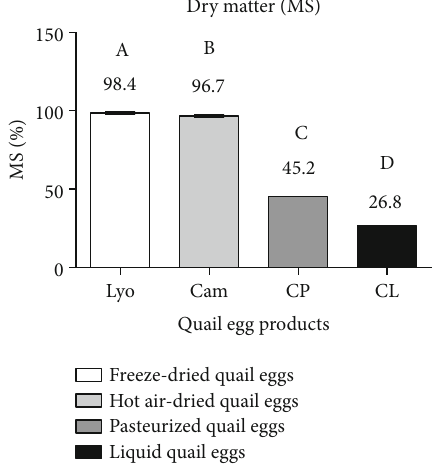
Figure 4: Dry matter content of liquid (CL), freeze-dried (Lyo), hot air-dried (Cam), and pasteurized (CP) quail eggs. Figure 4 reveals that freeze-dried ( 98 : 4 ± 0 : 78 % ) and hot air-dried ( 96 : 7 ± 0 : 76 % ) quail eggs had the highest dry mat- ter contents compared to pasteurized ( 45 : 2 ± 0 : 06 % ) and liq- uid ( 26 : 8 ± 0 : 01 % ) quail eggs. A signi fi cant di ff erence